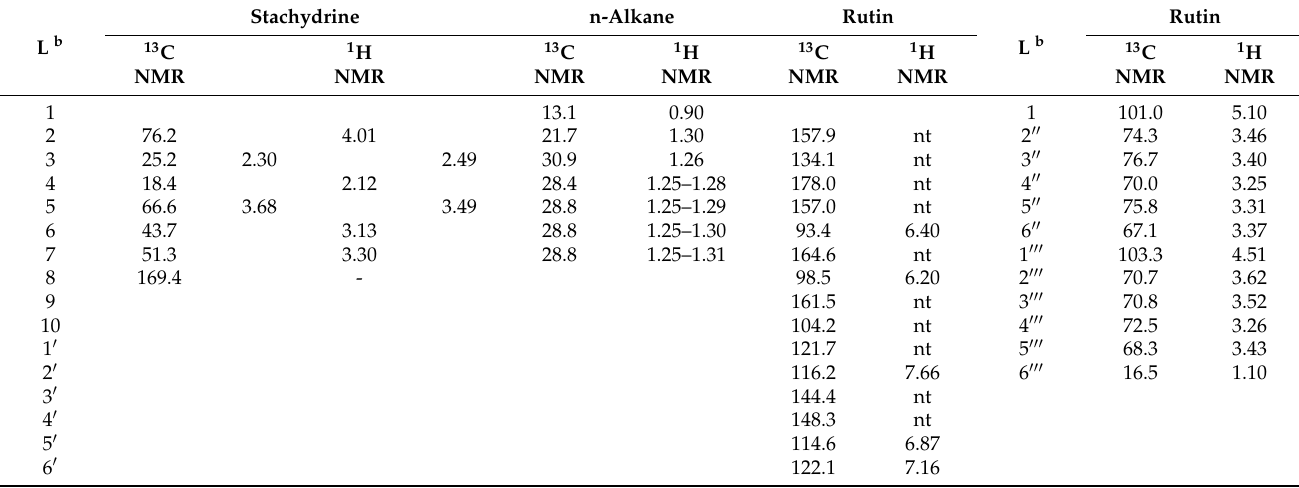
Table 2. NMR spectroscopic data a for the compounds present in M8R sub-fraction isolated from S. spinosum .